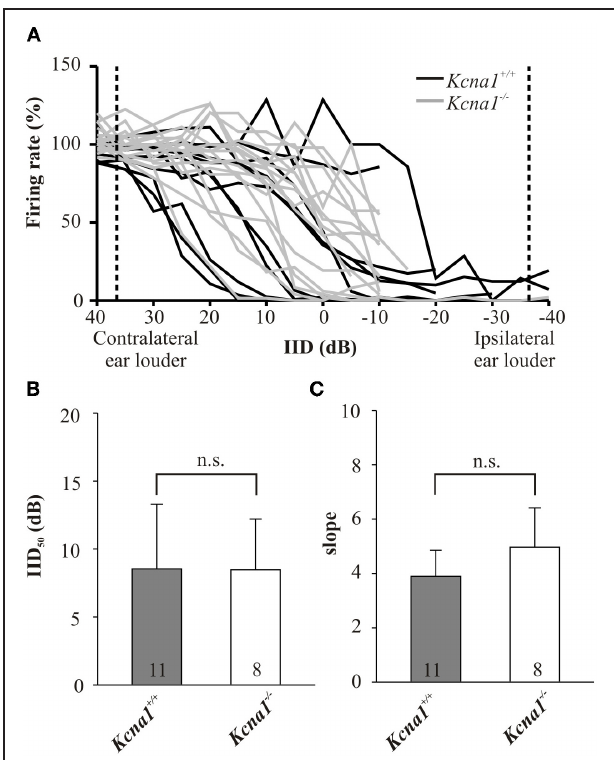
FIGURE 1 | (A–C) Q2 IID-sensitivity of IC neurons in wild-type and Kcna1 − / − mice. (A) IID functions obtained from the IC of Kcna1 + / + (black curves) and Kcna1 − / − mice (gray curves) are equally distributed between negative and positive IIDs. Dotted lines represent the range of IIDs which a small headed species such as the mouse could possibly encounter in a natural environment (Chen et al., 1995). (B) IID curves were fitted by a 4-parametric sigmoid function from which IID values corresponding to a 50% rate reduction (IID 50 ) were determined. No genotype specific differences were found. (C) The slope of the IID functions (determined from the sigmoid fit) was also not significantly different between the two